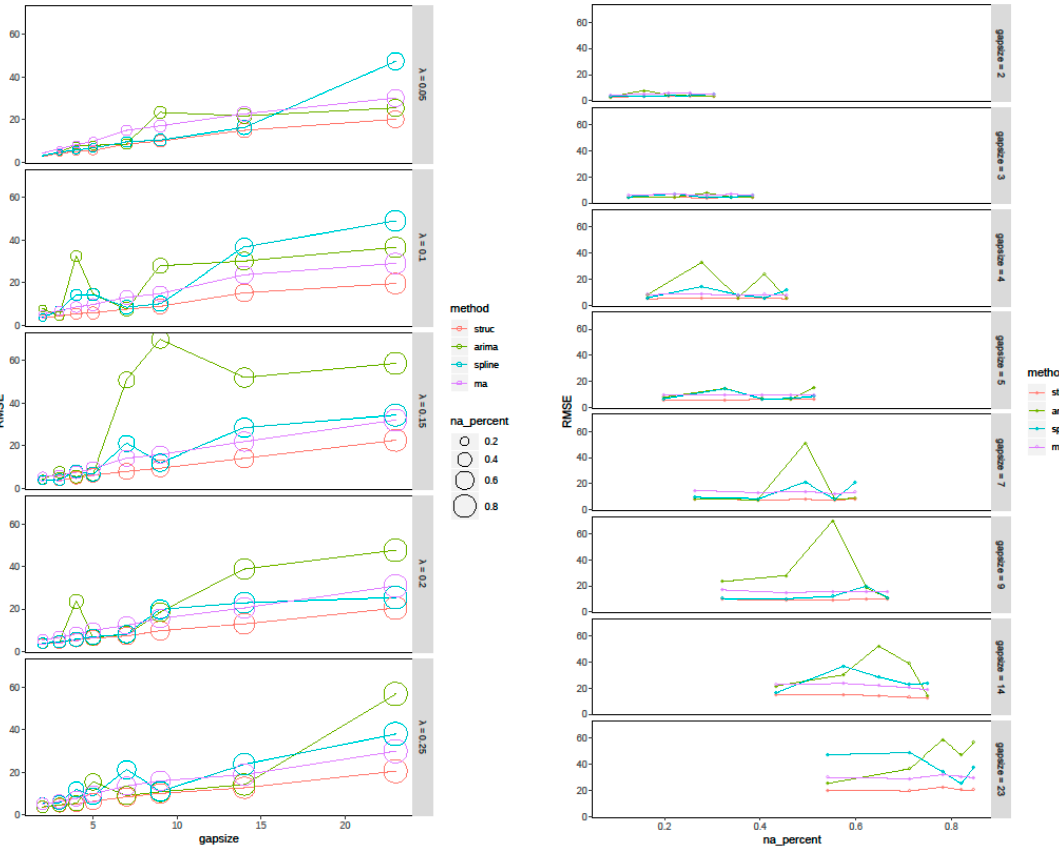
Figure 9. Sensitivity of gap size/existing data percentage on the data imputation